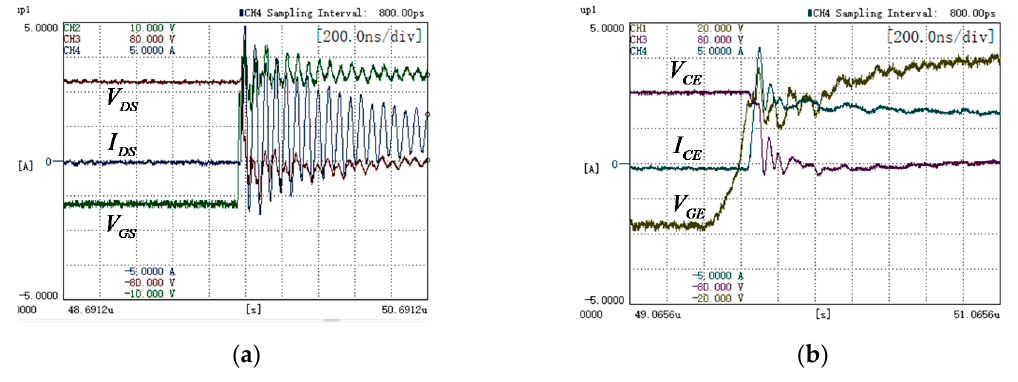
Figure 5 . Experimentally measured turn-on waveform. ( a ) GaN, ( b ) IGBT. Figure 5. Experimentally measured turn-on waveform. ( a ) GaN, ( b ) IGBT.